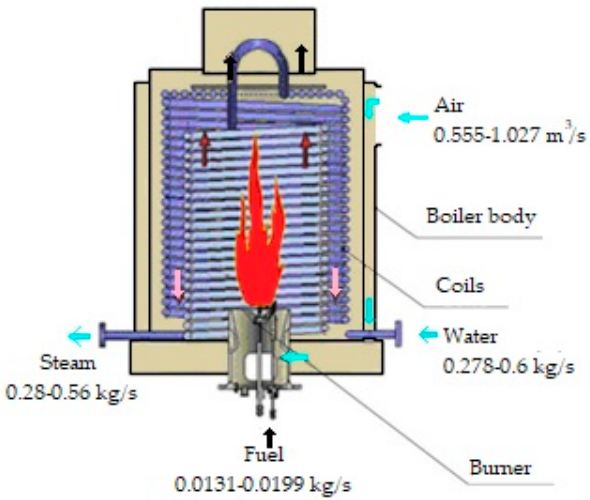
Figure 1. Coil ‐ type steam boiler. Figure 1. Coil-type steam boiler.